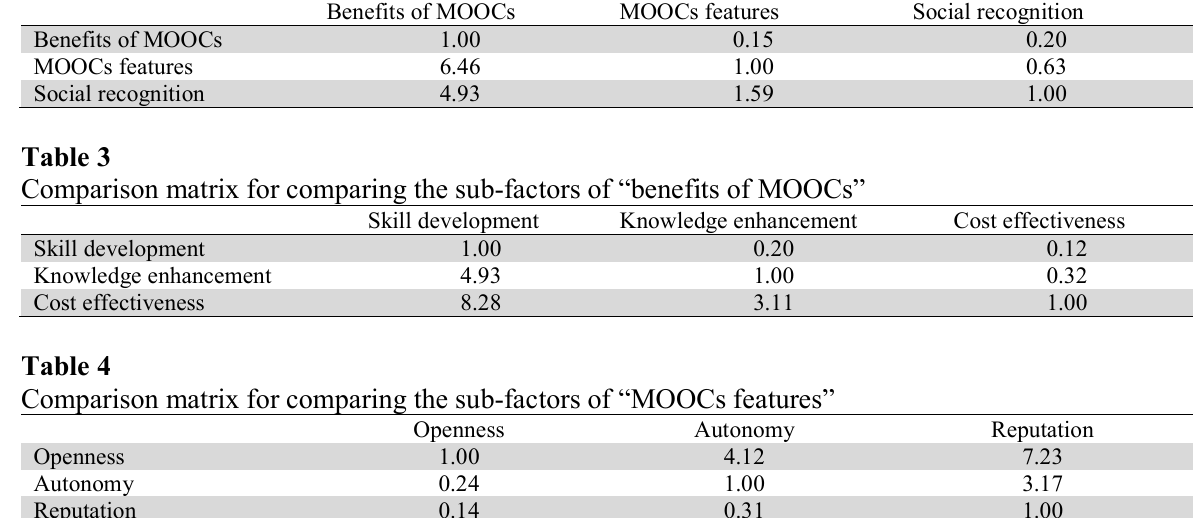
Openness Autonomy